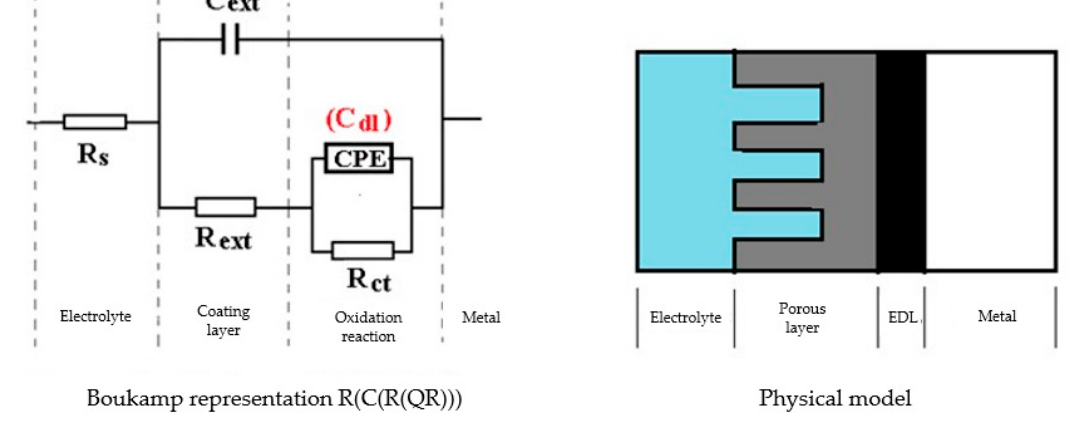
Figure 5. The equivalent circuit for C45 sample, after 43 days of immersion in BSW.